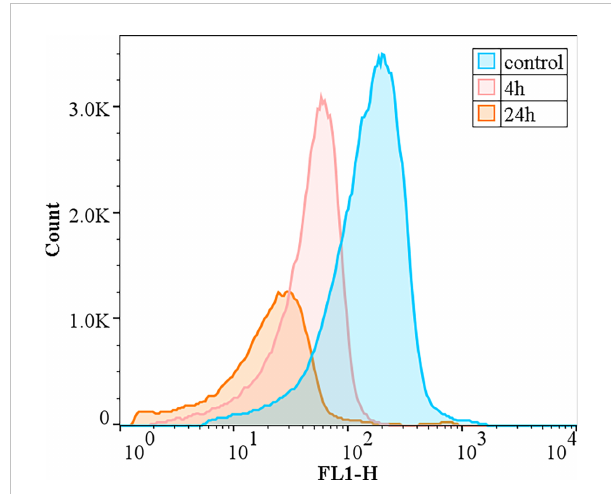
FIGURE 7 Effect of the algicidal substances on the activity of